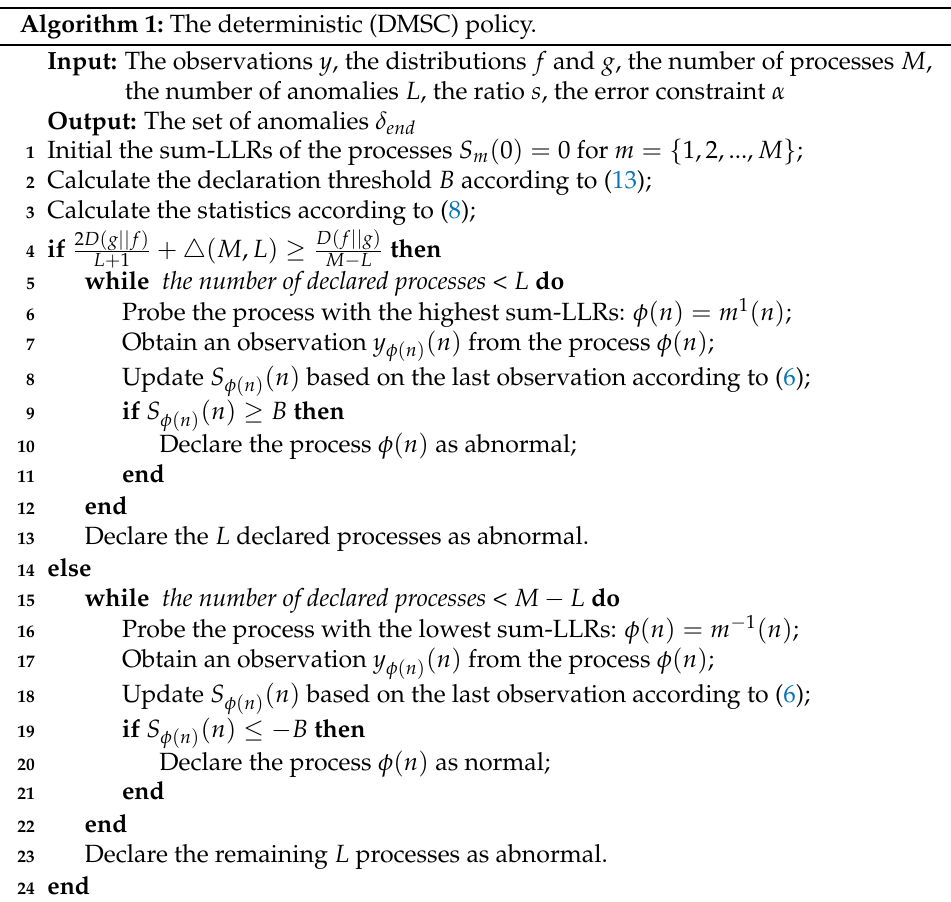
Algorithm 1: The deterministic (DMSC)